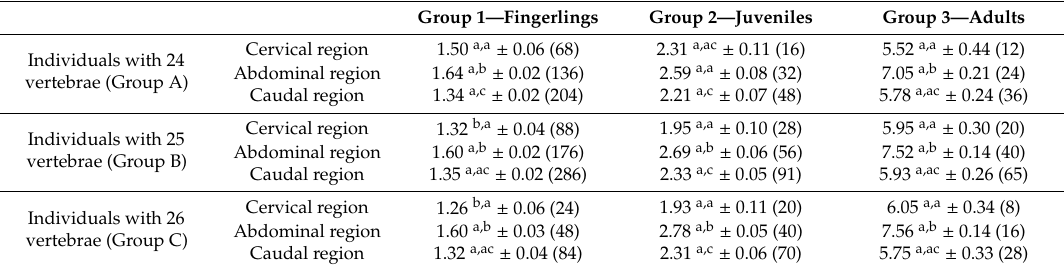
Table 2. Mean length of vertebrae (mm) of European seabass individuals for each vertebral column region, grouped by age and total number of vertebrae.